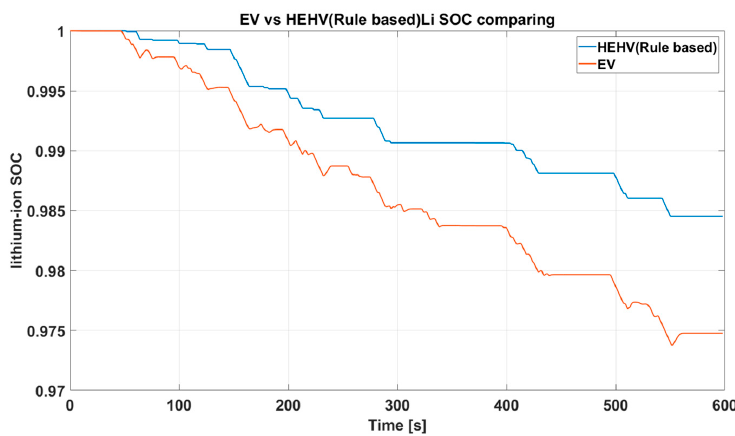
Figure 10. Electric motor power comparison of EV and HEHV.